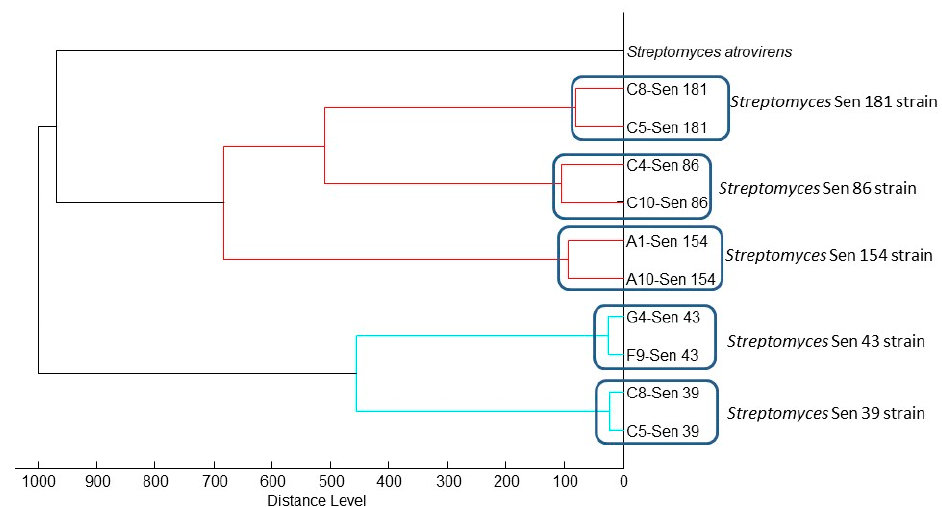
Figure 2. Dendrograms for the Streptomyces strains generated using the MALDI Biotyper 3.0 software, with Streptomyces atrovirens as the outgroup.